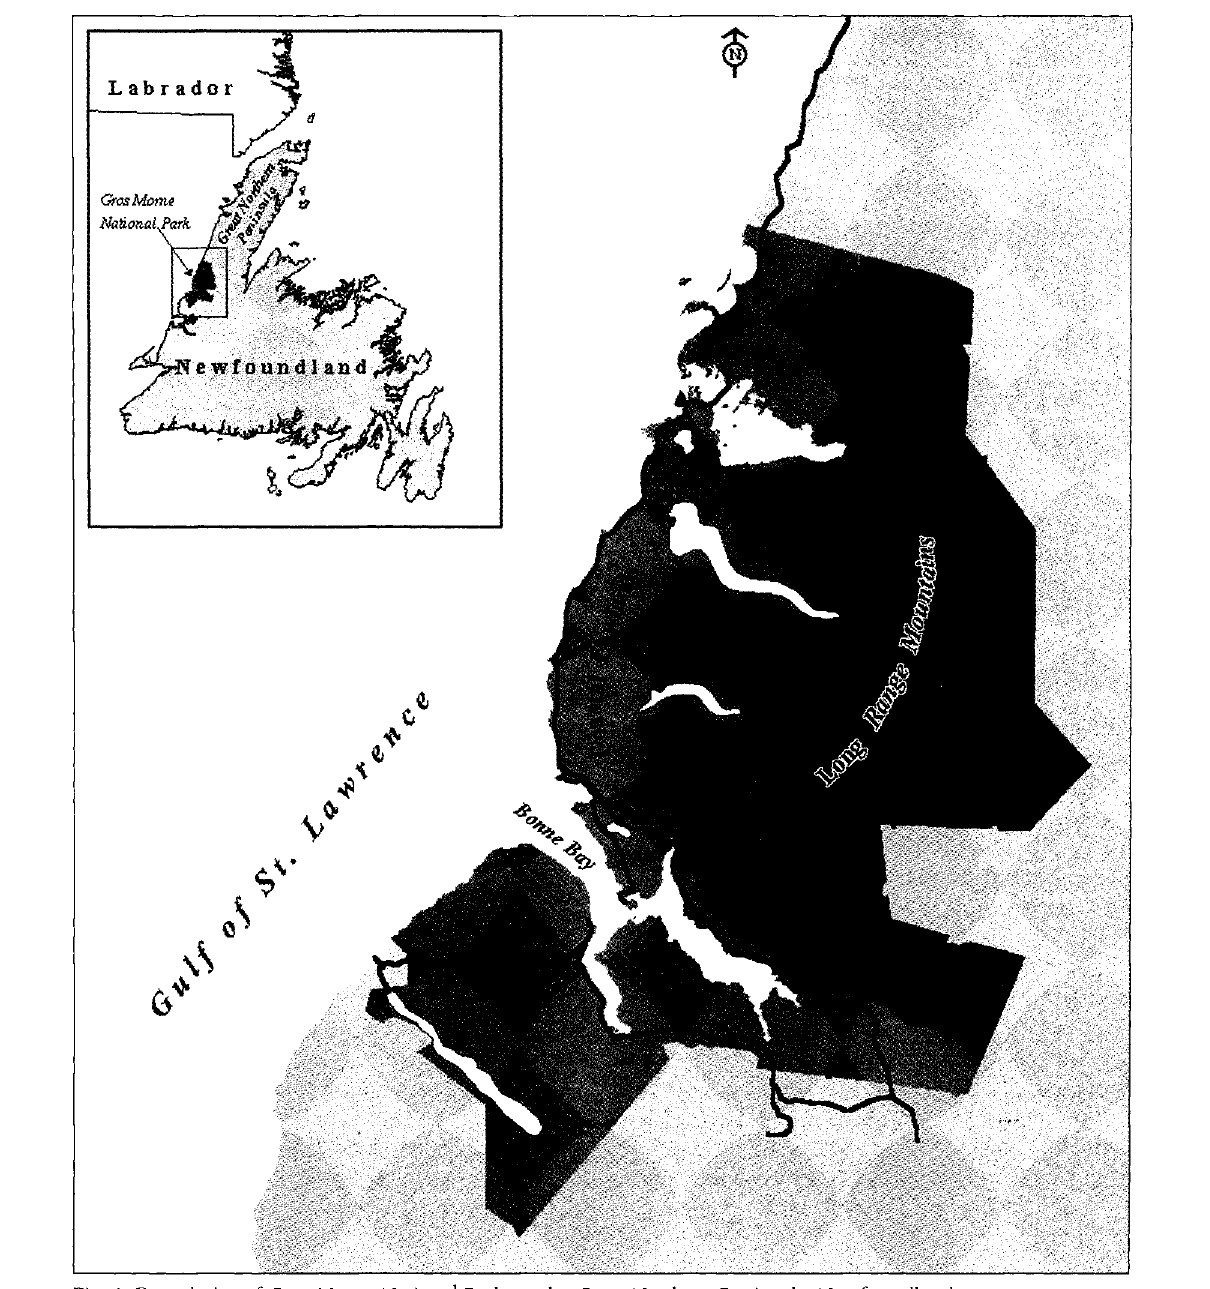
Fig. 1. Boundaries of Gros Morne National Park on the Great Northern Peninsula, Newfoundland.